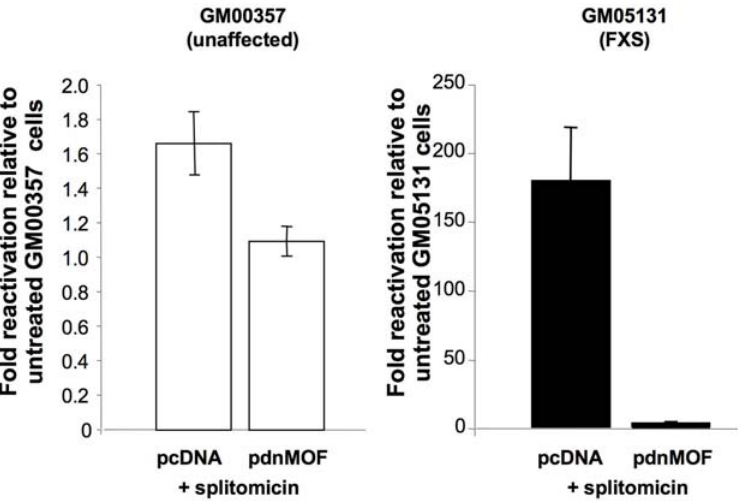
Figure 6. The effect of hMOF on splitomicin-mediated FMR1 gene reactivation. Fibroblasts from affected and unaffected individuals were treated with 700 m M splitomicin after being transfected with either empty pcDNA3 vector or with the vector containing a dominant negative version of hMOF. The FMR1 expression was measured by real time PCR and expressed as the fold change relative to the levels of FMR1 seen in cells without splitomicin treatment.